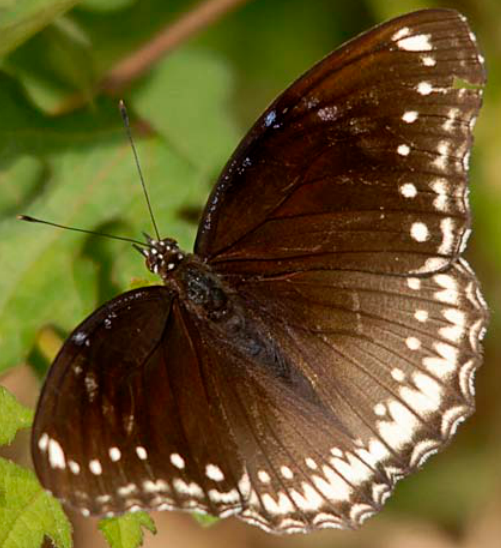
Image 15. Choclate Pansy Junonia